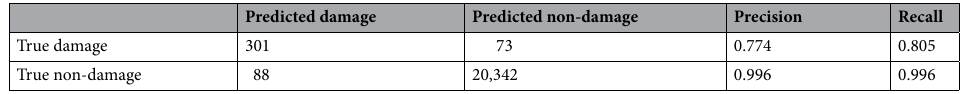
Table 1. Confusion matrix for the twitter test dataset after removing duplicate